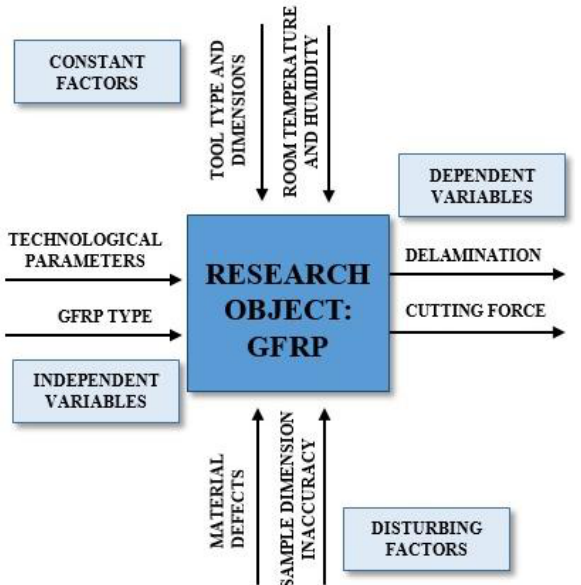
Figure 1. Research plan for the analysis of cutting forces and delamination during drilling of GFRP.